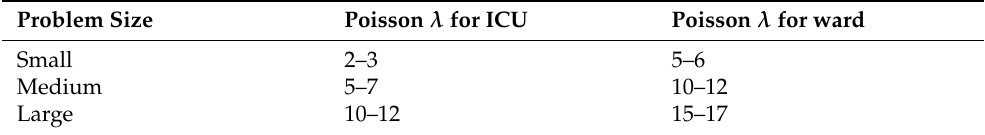
Table 3. Value of λ for different problem